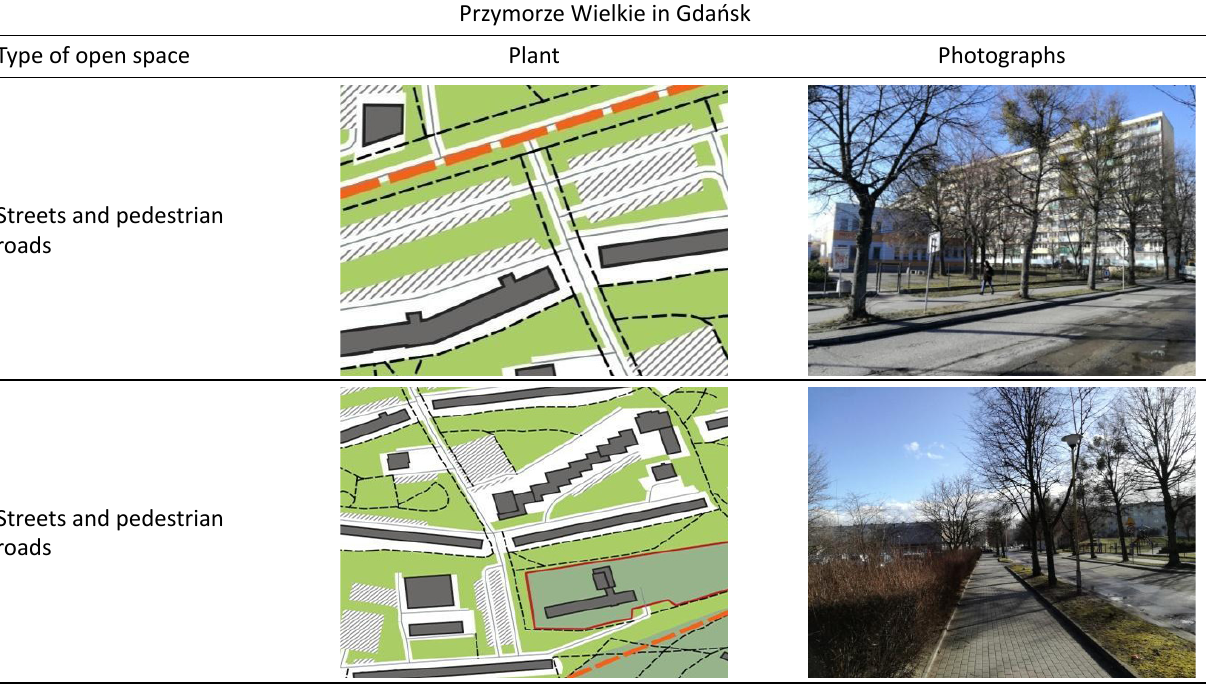
Table 3. (Cont.) Forms of open spaces.